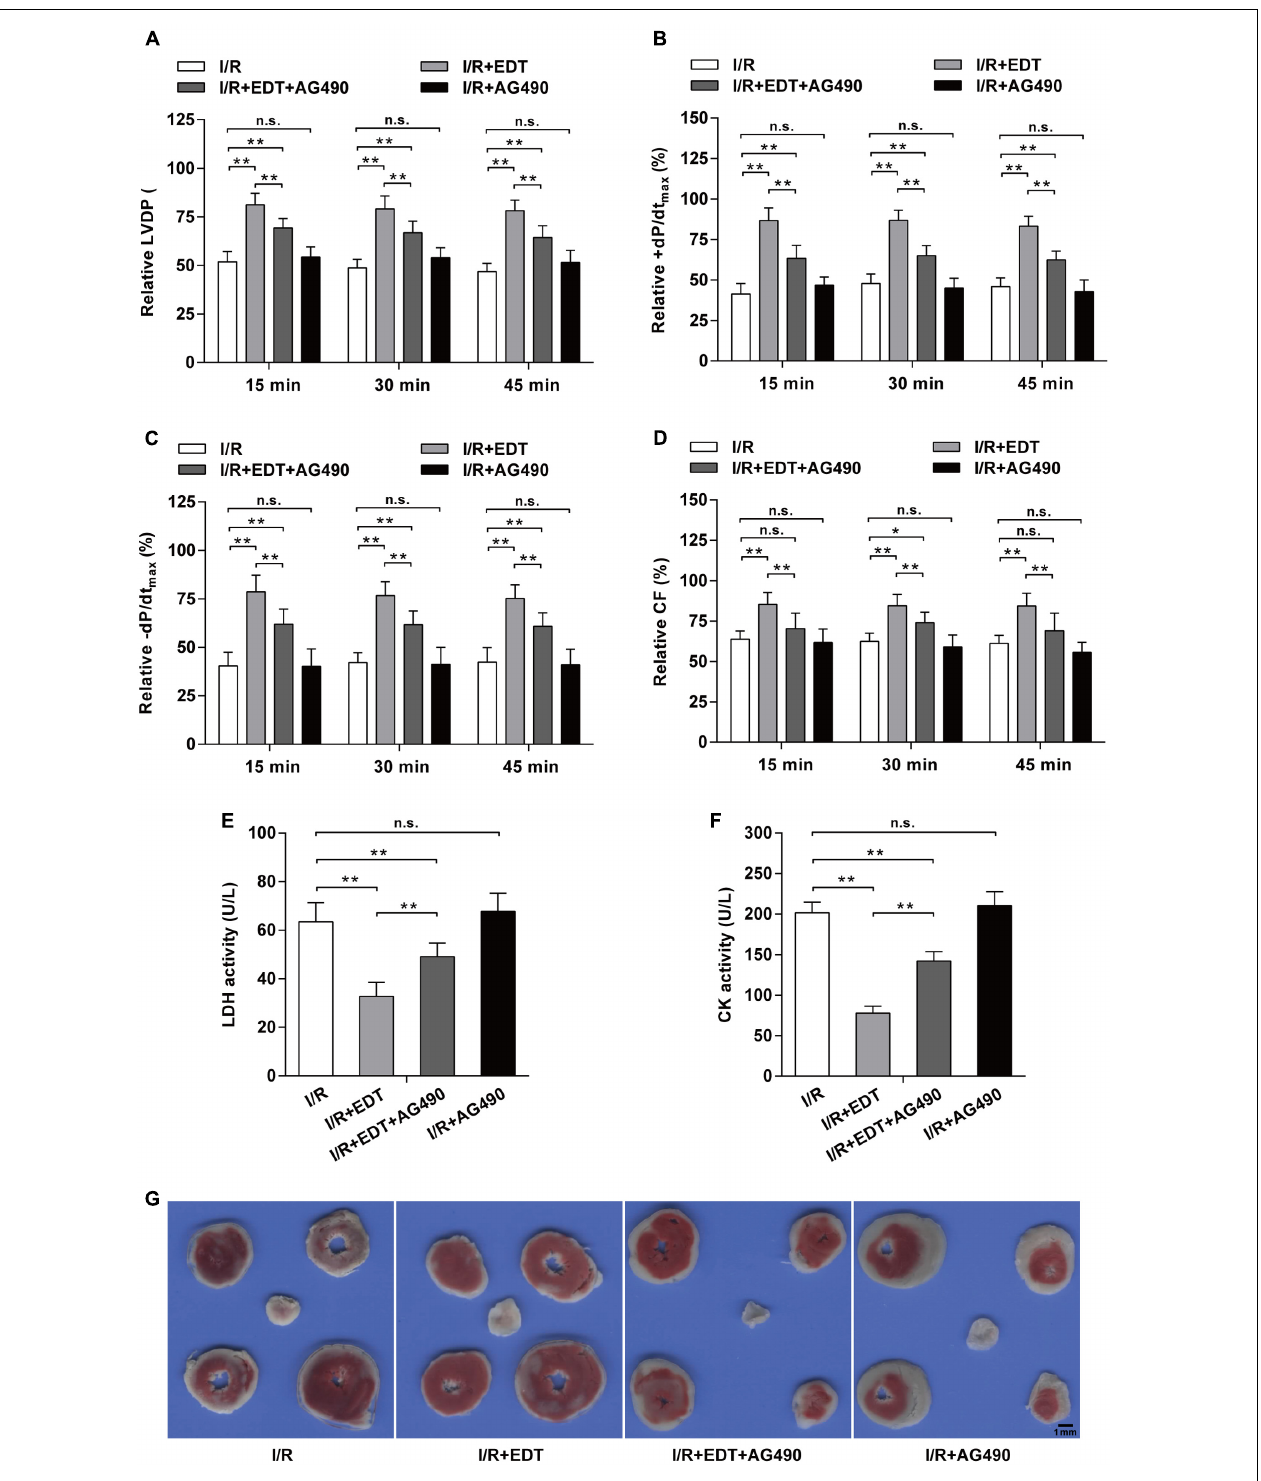
FIGURE 5 | JAK2 specific inhibitor AG490 abolishes the protective effect of EDT in myocardium I/R injury. The values of LVDP (A) , + dP/dt max (B) , − dP/dt max (C) , and CF (D) in rat hearts were measured after co-treatment with EDT and AG490. The values of these parameters were normalized to the values of the recorded data before 15 min of zero-flow global ischemia. The levels of LDH (E) and CK (F) in K–H buffer were determined after co-treatment with EDT and AG490. (G) The infarct size was examined by TTC staining after co-treatment with EDT and AG490. Scale bar: 1 mm. n = 8 for each group. All data are the mean ± SD. ∗ P < 0.05, ∗∗ P <